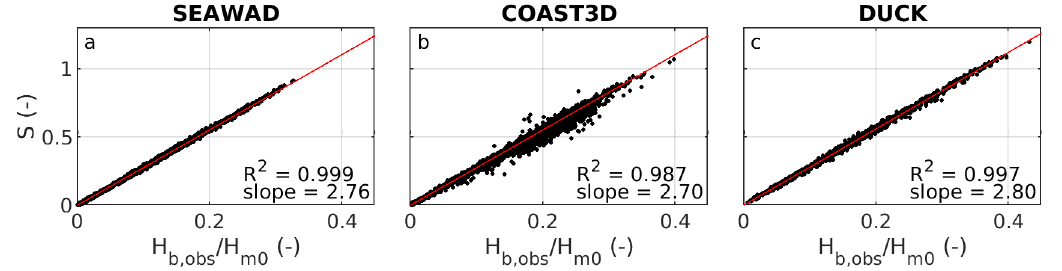
Figure 10. Dimensionless wave shape as a function of the dimensionless observed bound wave height for the SEAWAD ( a ), COAST3D ( b ), and SandyDuck ( c ) field campaigns. The red lines are the best linear fit through the origin per